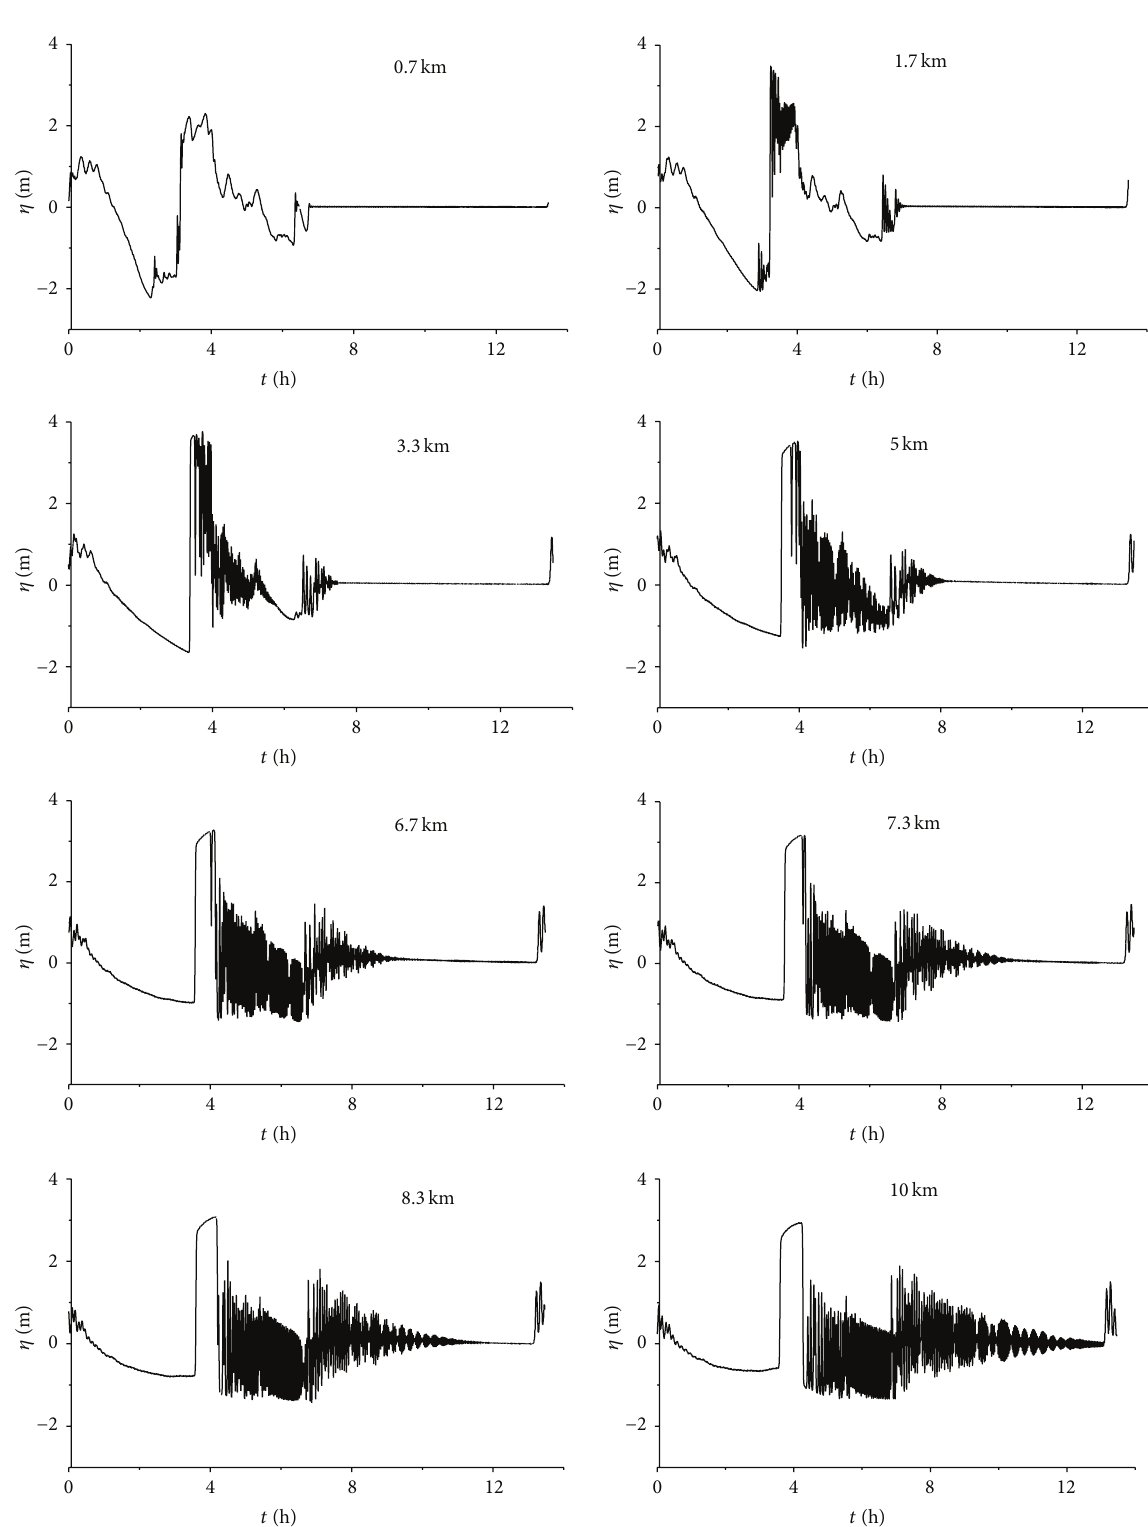
Figure 5: Transformation of internal wave from the point 𝑥 = − 10km to 𝑥 =